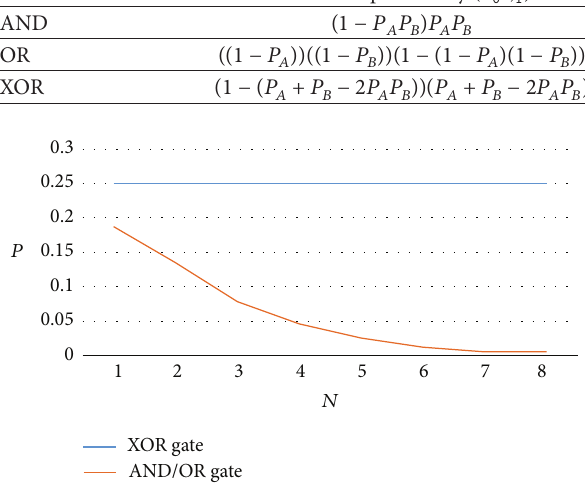
Figure 2: Activity as a function of topology [11].